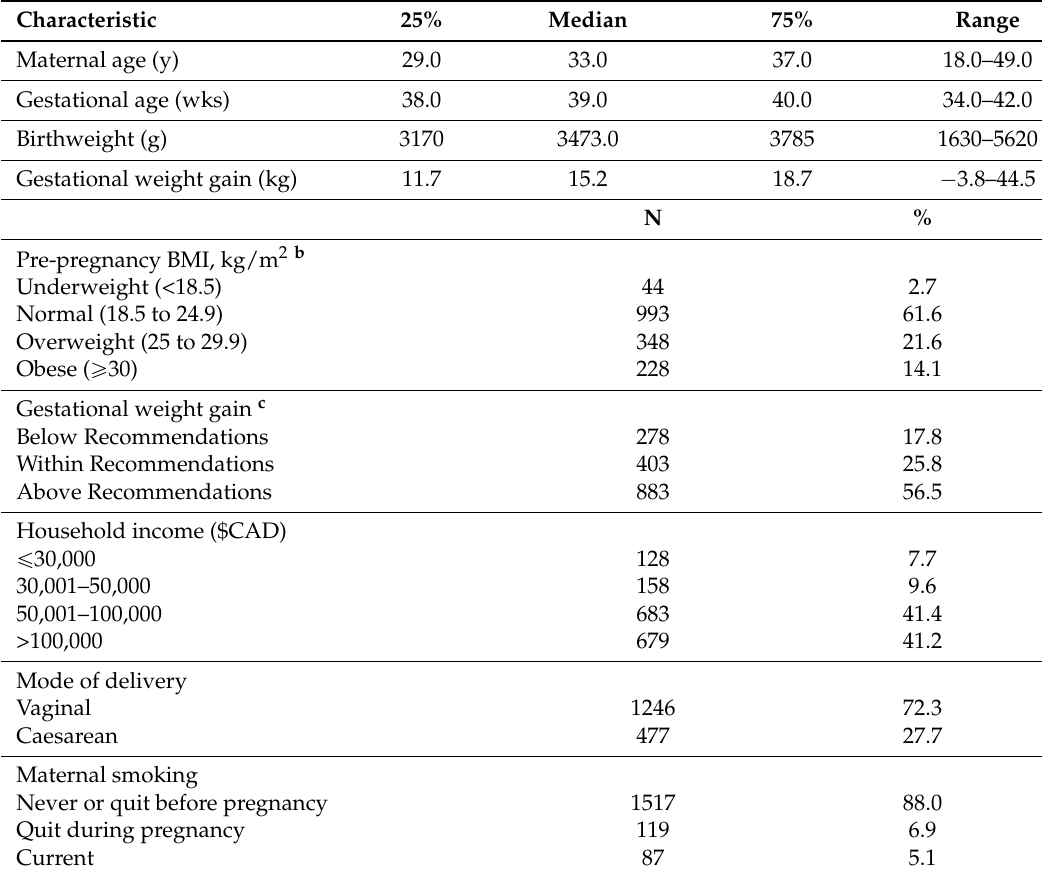
Table 1. Characteristics of study participants, MIREC study, 2008–2011 ( N = 1723) a